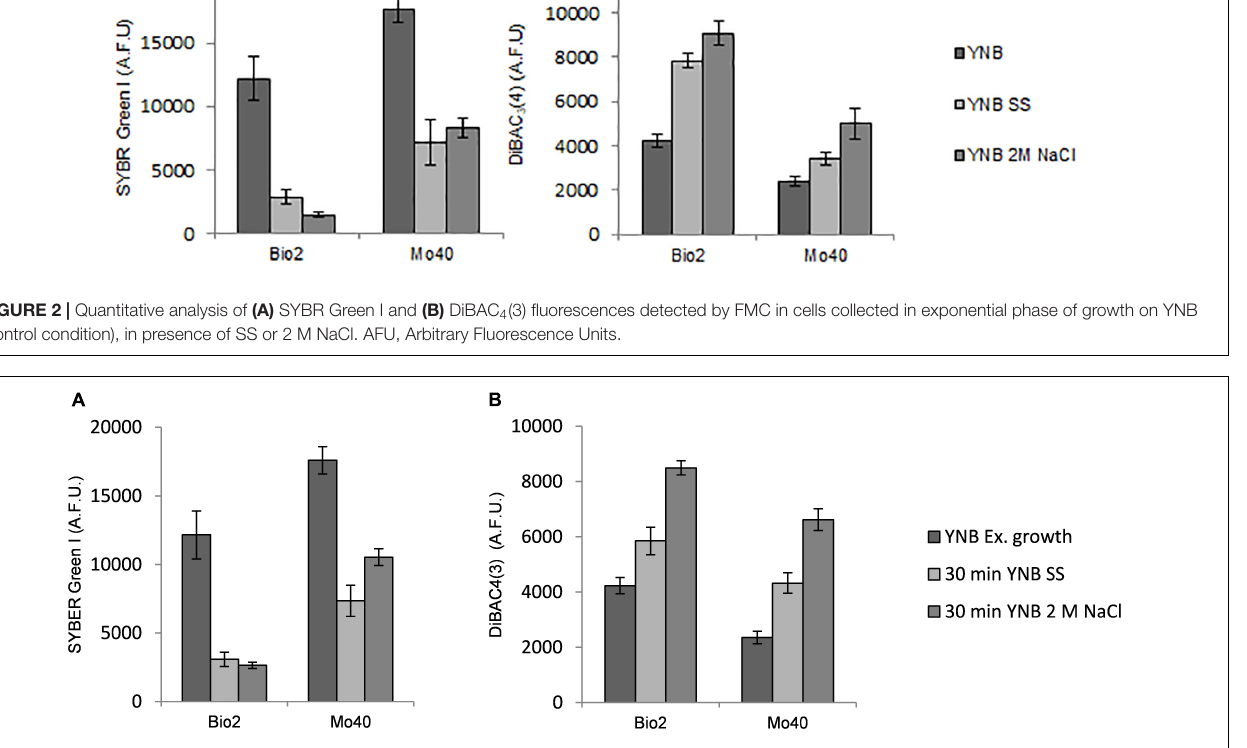
FIGURE 3 | Quantitative analysis of (A) SYBR Green I and (B) DiBAC 4 (3) fluorescences detected by FMC after exposure to hyper-osmotic stress (SS or 2 M NaCl). AFU, Arbitrary Fluorescence Units.